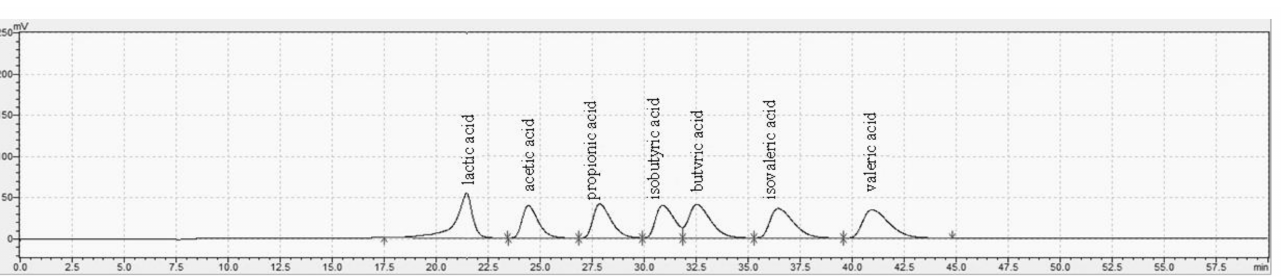
Figure 2. A representative HPLC chromatogram of lactic acid and SCFAs determination in rat feces, using a Refractive Index Detector